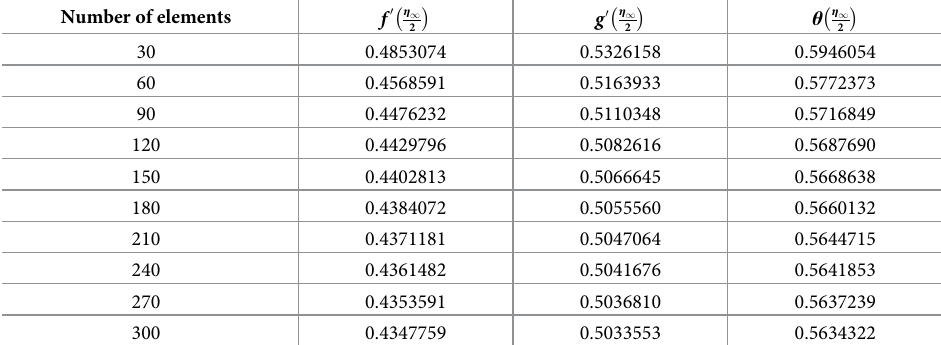
Table 2. Convergence analysis of velocities and thermal energy considering 300 elements.